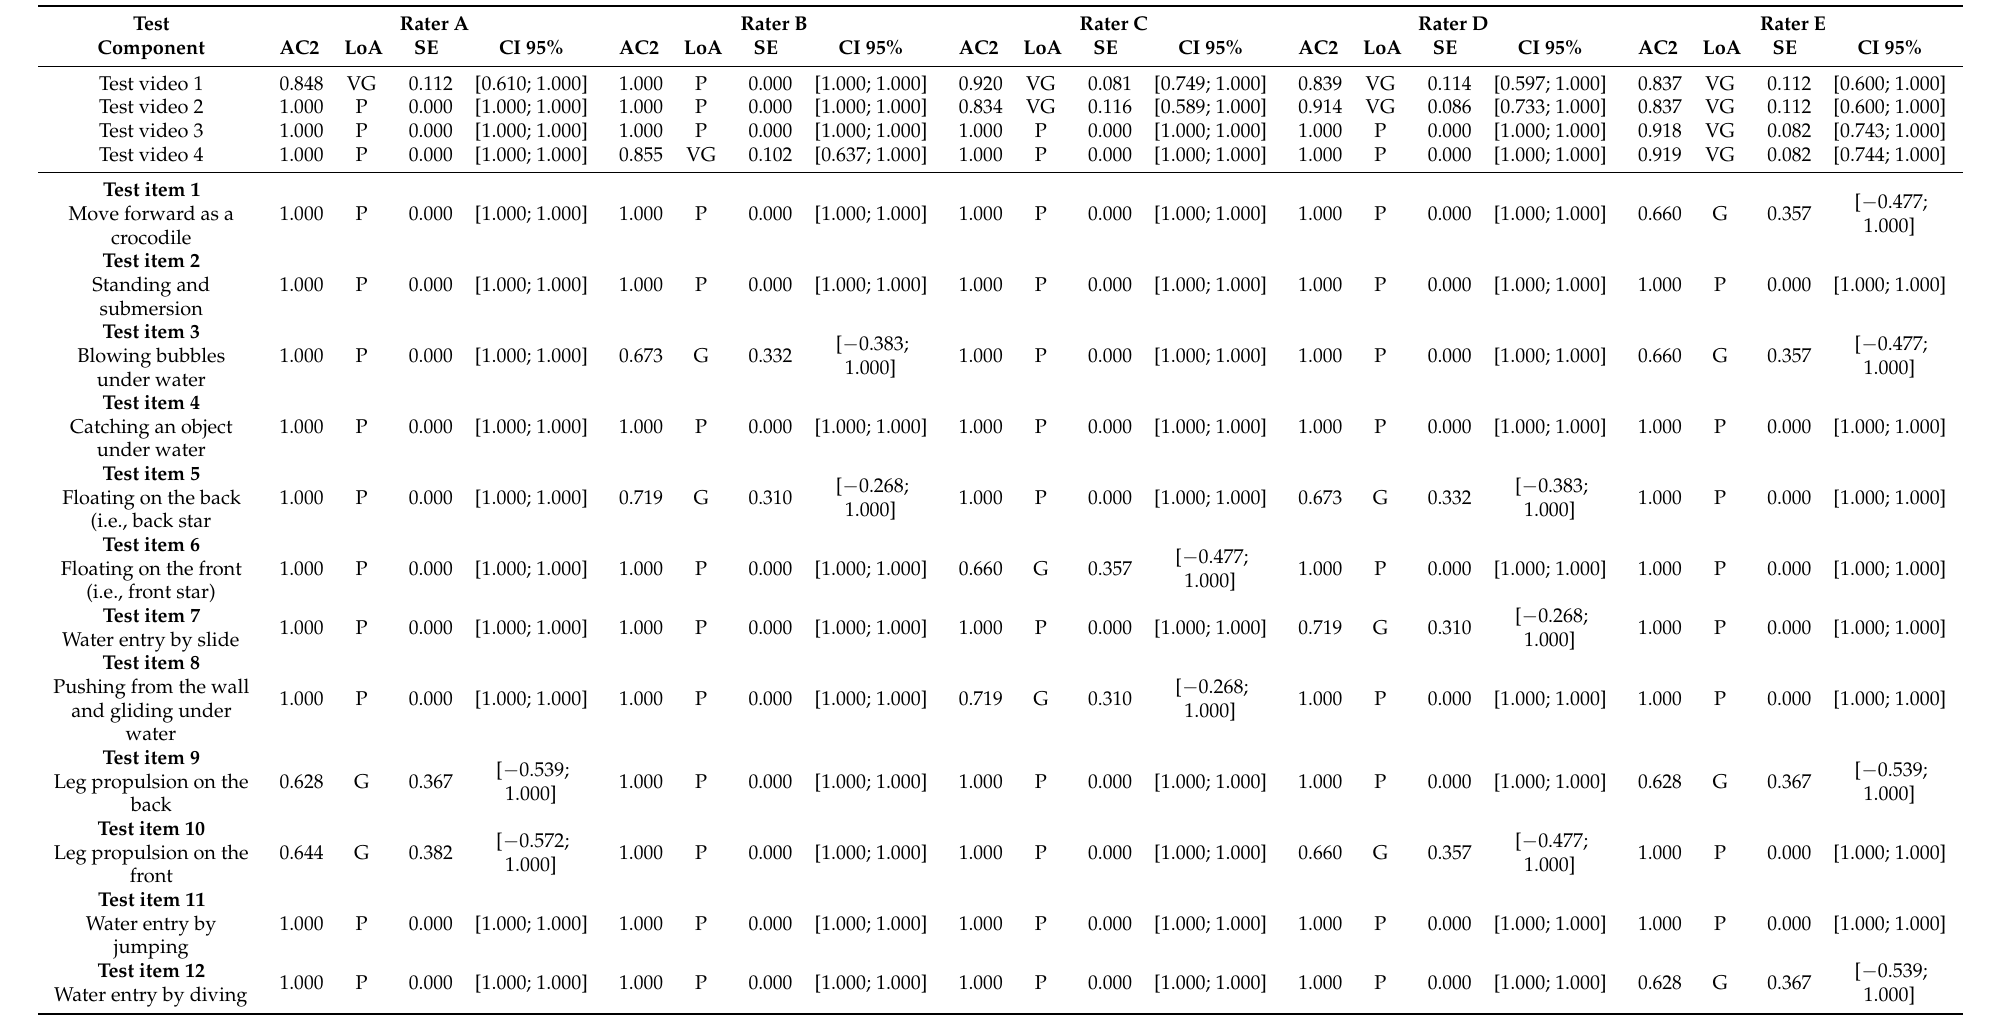
Table 6. Gwet’s AC2 test results for intra-rater